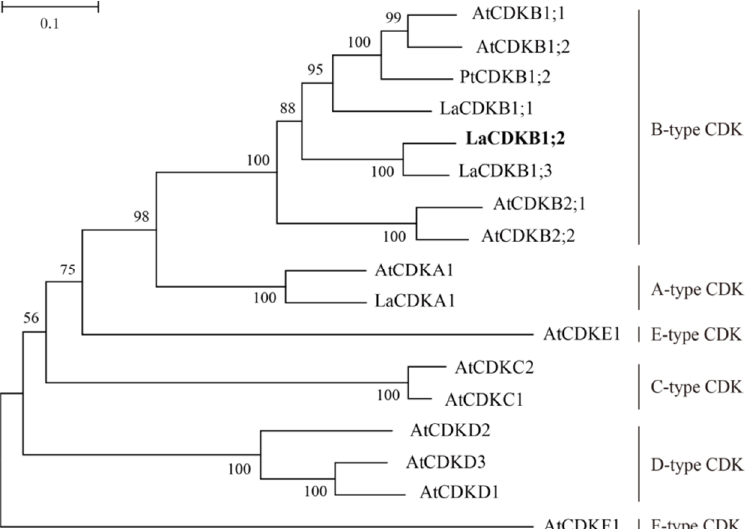
Figure 2. Phylogenetic analysis of LaCDKB1;2. The tree was constructed with 17 amino acid se- quences of CDKs using the neighbor-joining method with MEGA6.0. Values at each node are bootstrap support percentages from 1000 replications. Species and accession numbers: L. keampferi (LaCDKB1;1, MW132640; LaCDKB1;2, MW132641; LaCDKB1;3, MW132642; LaCDKA1, MW132639), A. thaliana (AtCDKB1;1, AT3g54180; AtCDKB1;2, AT2g38620; AtCDKB2;1, AT1g76540; AtCDKB2;2, AT1g20930; AtCDKA1, AT3g48750; AtCDKE1, AT5g63610; AtCDKC2, AT5g64960; AtCDKC1, AT5g10270; AtCDKD2, AT1g66750; AtCDKD3, AT1g18040; AtCDKD1, AT1g73690; AtCDKF1, AT4g28980), and P. trichocarpa (PtCDKB1;2, U5FL09).